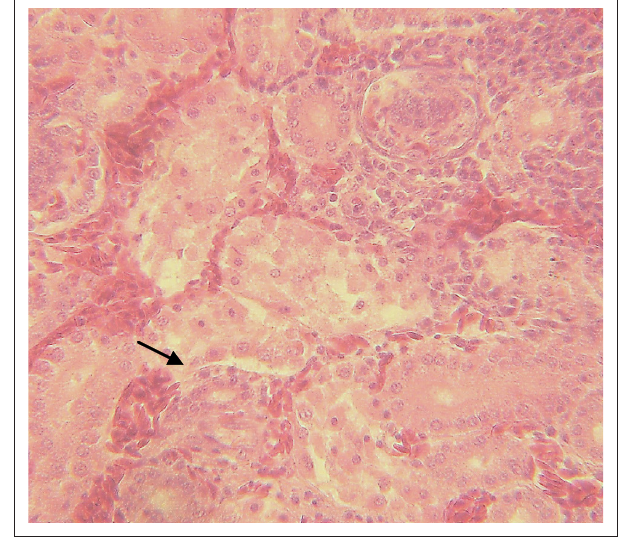
FIGURE 3: Congestion, haemorrhage and focal necrosis of urinary tubules (arrow) and lymphocyte infiltration in the kidney, 10 days post-inoculation.